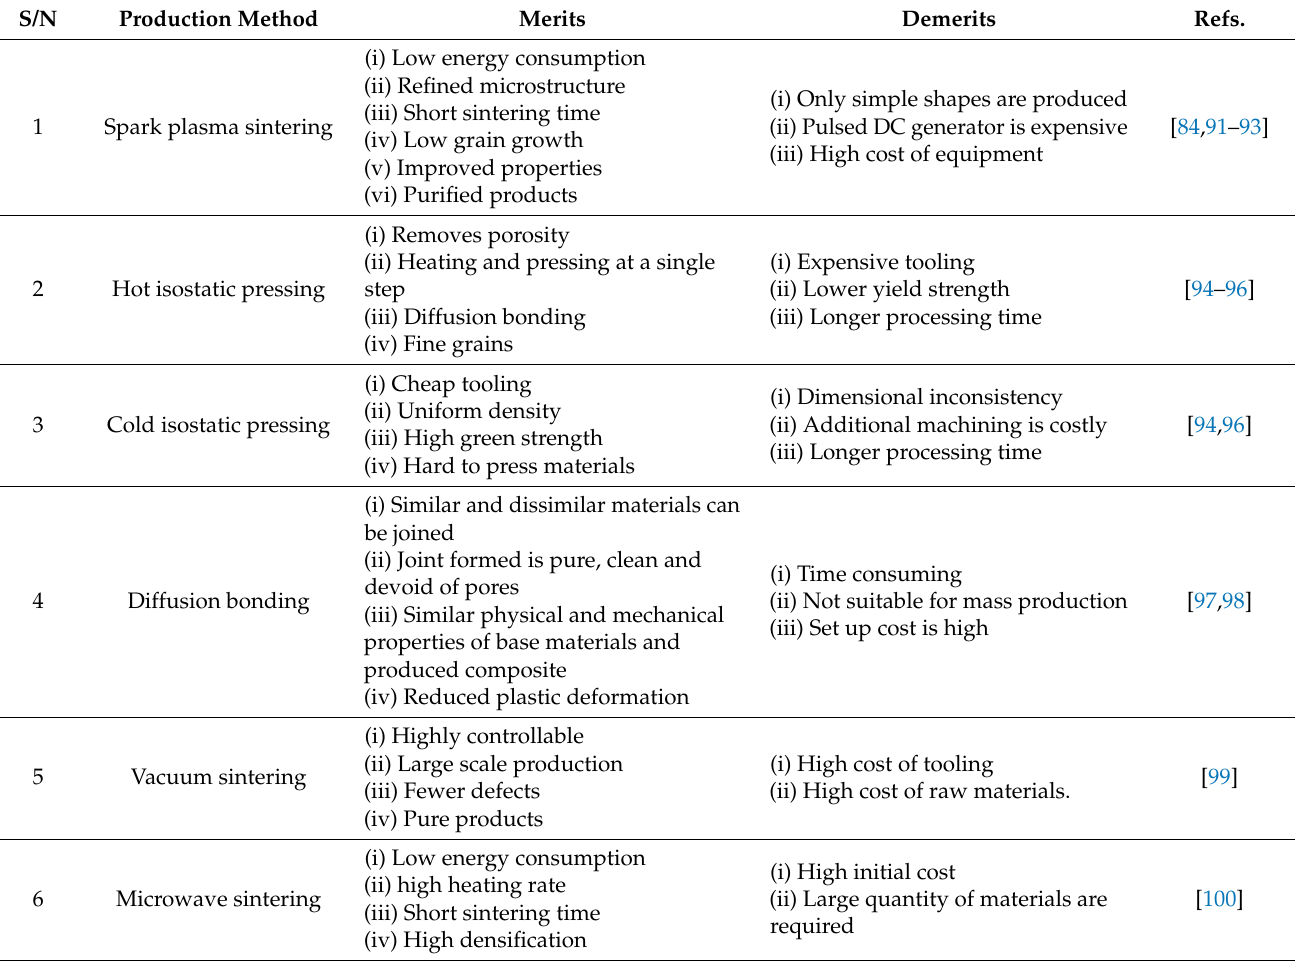
Table 3. Further Solid-State Production